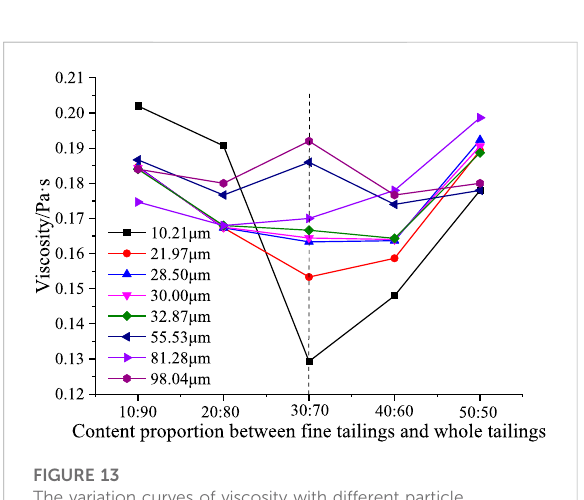
FIGURE 13 The variation curves of viscosity with different particle diameters and